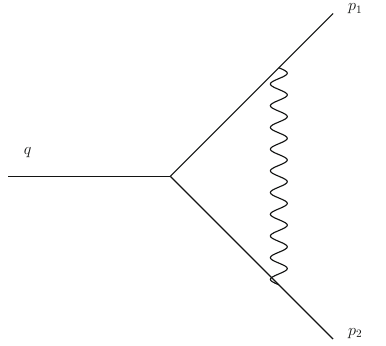
Fig. 1 A one loop vertex diagram . The internal solid lines have mass m and the wavy line is massless